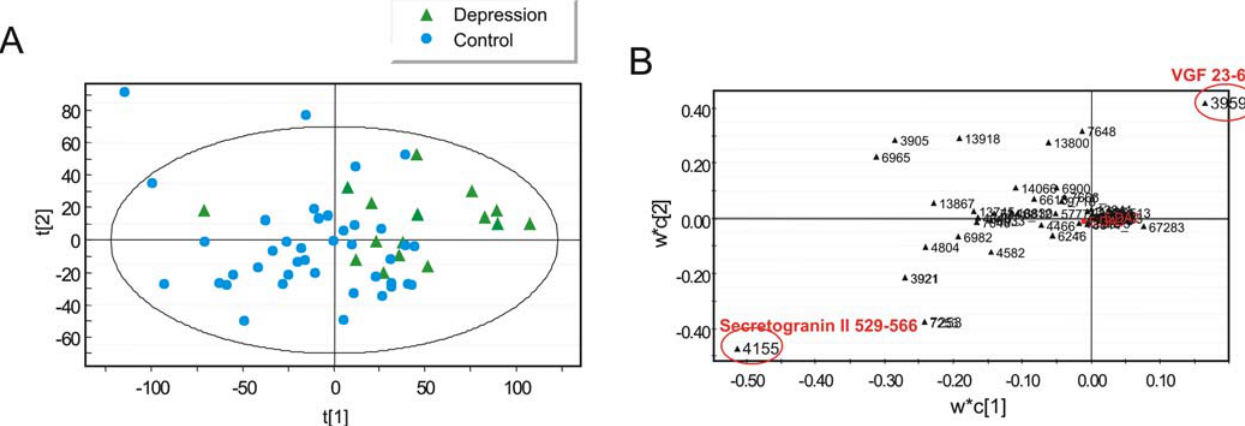
Figure 7. CSF Proteomic Profiles of Depression Patients CSF samples from 16 patients with depression (green triangles), together with 40 healthy volunteers (blue dots), were analyzed with SELDI-MS using Q10 anion exchanger protein chips at pH 9 (50 mM Tris-HCl). (A) The scores plot shows a partial separation between controls and patients with schizophrenia. (B) The loading plot indicates VGF23–62 and a depression-specific secretogranin II 529–566 peptide to be the key protein/peptide peaks contributing the most towards the group separation.